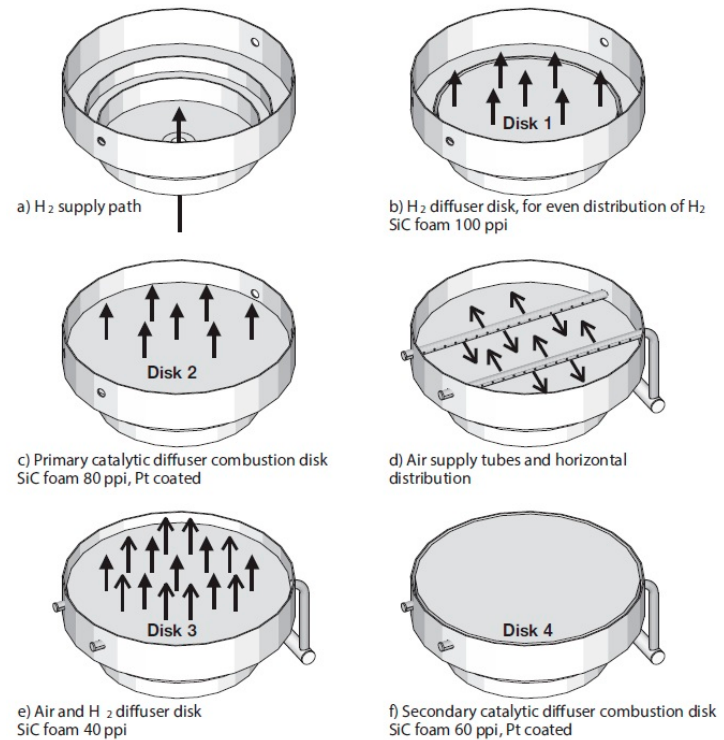
Figure 17. Schematic of the catalytic hydrogen burner with Pt/SiC foam disks (reproduced from [147] with permission from Elsevier).